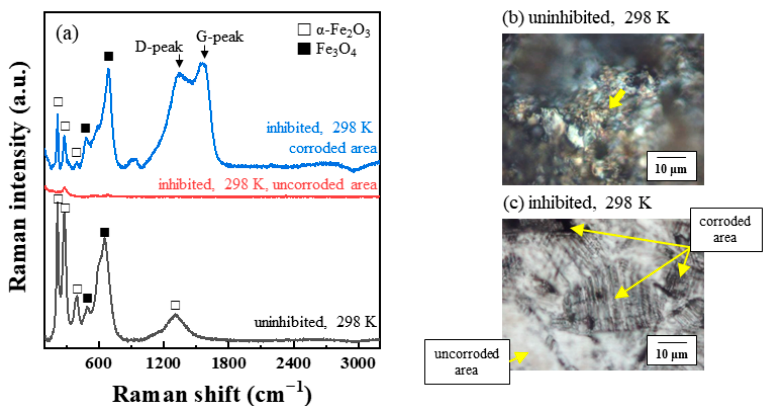
Figure 9. (a ) Raman spectra analyzed from the surface of MS specimens after immersion for 24 h in 1 M HCl solution at 298, 323, and 333 K with 0.75 g/L of tea tree extract. ( b – e ) OM images showing the surface morphology of corroded MS specimens. The spots of Raman spectroscopic measurement are marked by arrows in OM images.